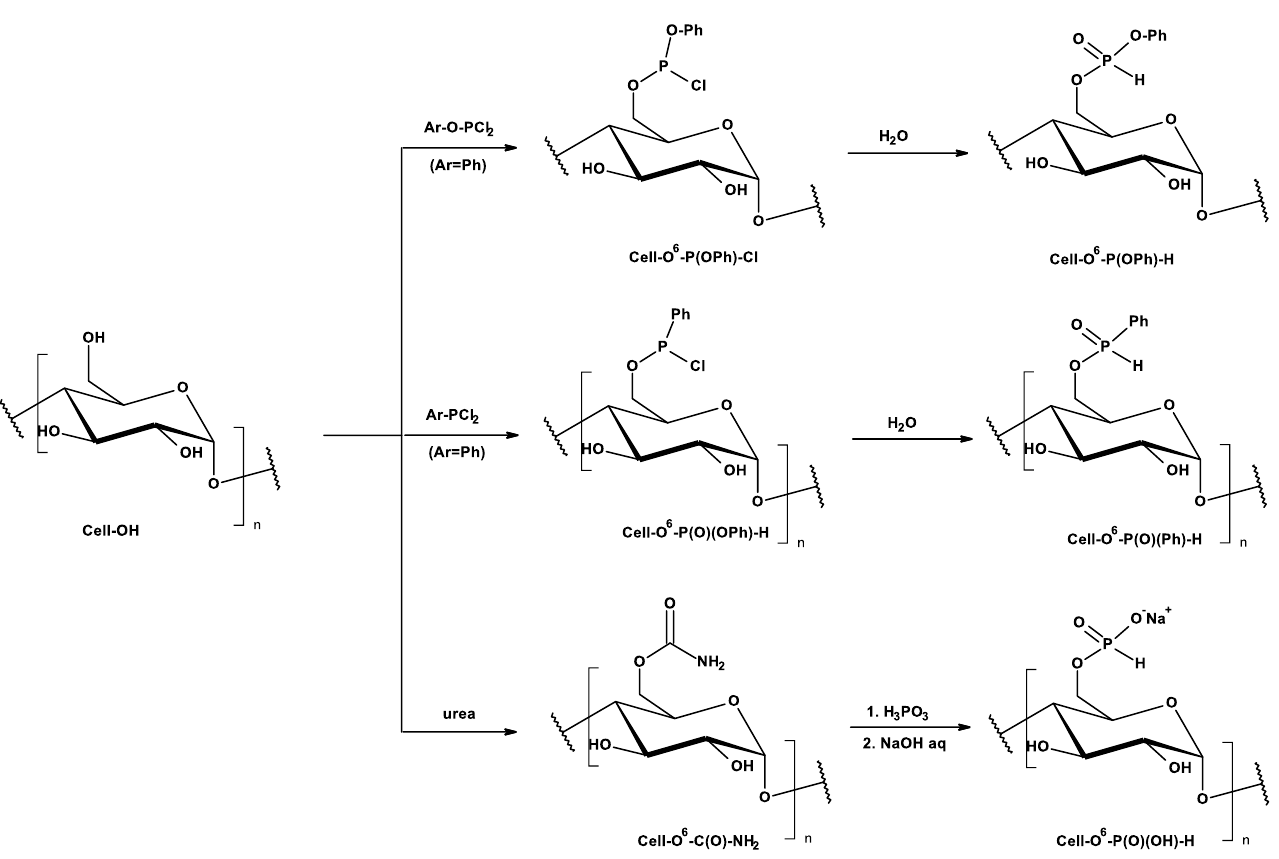
Figure 2. Major types of cellulose phosphorylations by P(III) reagents, assuming the formation of 6-esters of cellulose and phosphoric (III) acid — Cell- O 6 -P(O)(OH)-H (cellulose- O 6 -hydrogenphosphates (III), cellulose- O 6 -phosphates (III)) and/or esters of cellulose and aryloxy-phosphoric (III) acids (Ar-O-P(O)(OH)-H) - Cell- O 6 -P(O)(OAr)-H and C-phosphonic acids (Ar-P(O)(OH)-H) - Cell- O 6 -P(O)(Ar)-H. (In the path 3 the mixtures of Cell-O 2 -P(O)(OH)-H, Cell- O 3 -P(O)(OH)-H, and Cell- O 6 -P(O)(OH)-H were documented [33,34]).